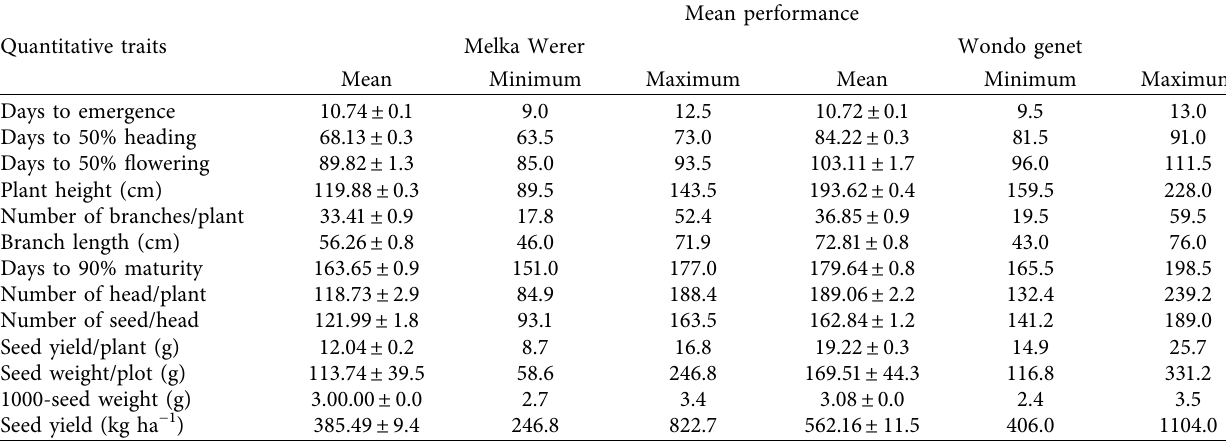
Table 2: Estimates of mean performance and ranges for 13 quantitative traits of Vernonia galamensis grown at Melka Werer and Wondo Genet agricultural research centers. Quantitative traits